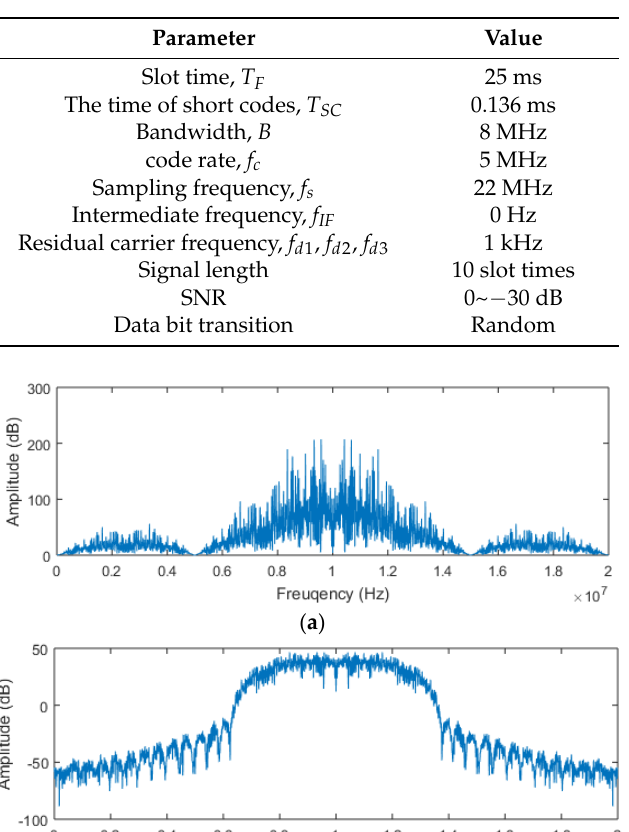
Table 1. Simulation parameters.